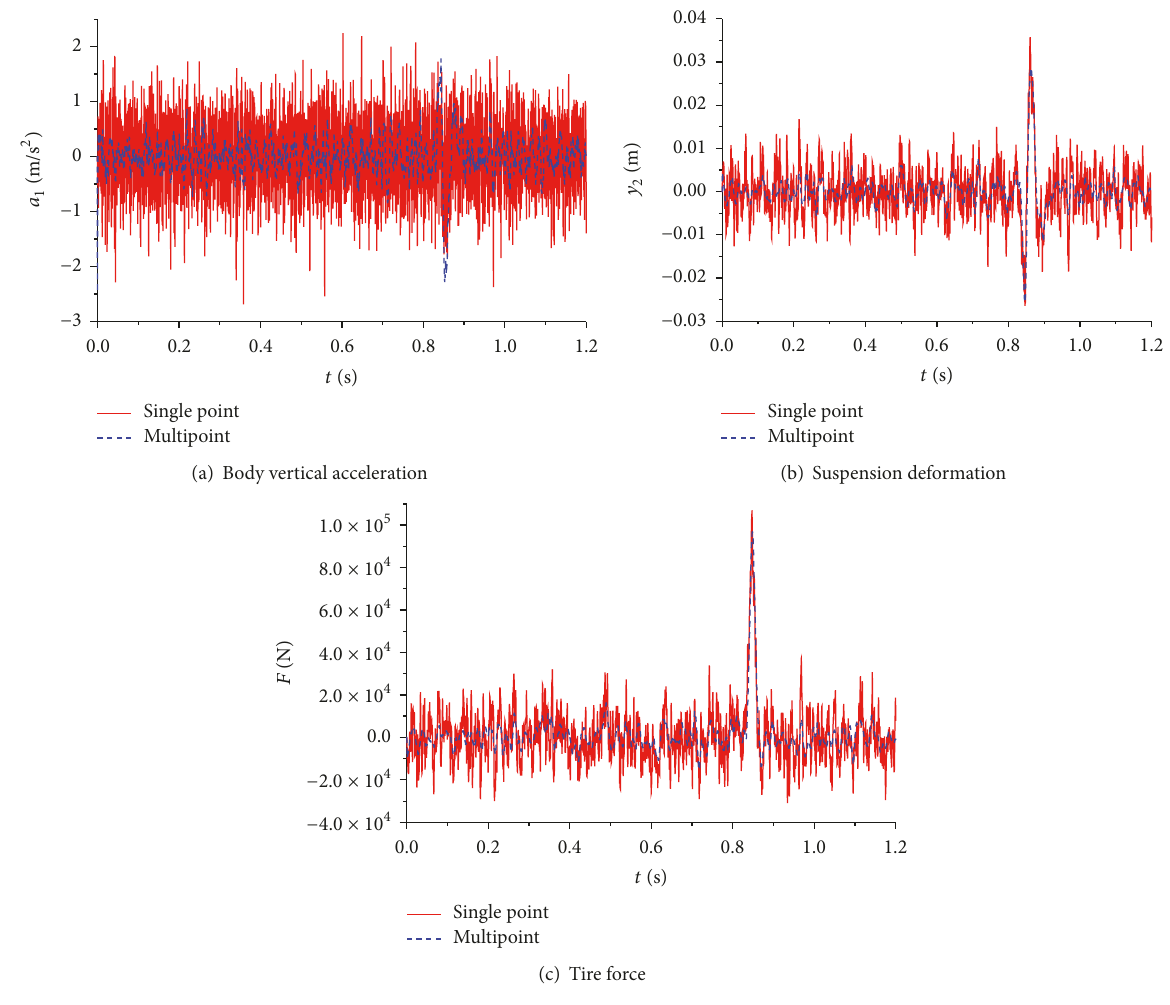
Figure 12: Vehicle-road response under bump